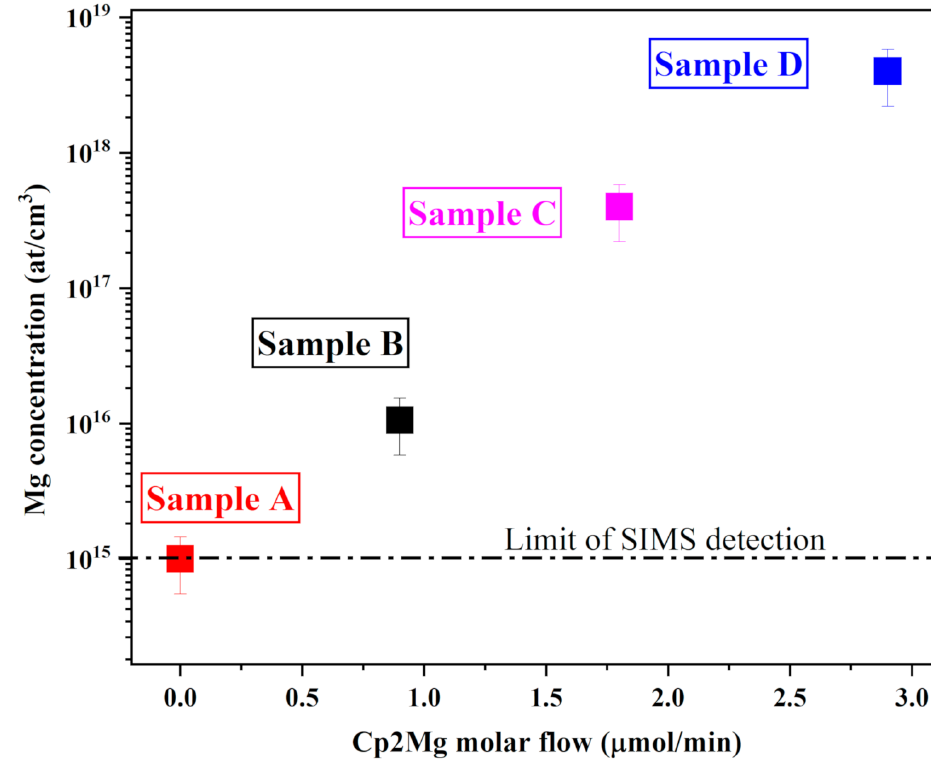
Figure 3. Cp2Mg molar flow dependence of the Mg